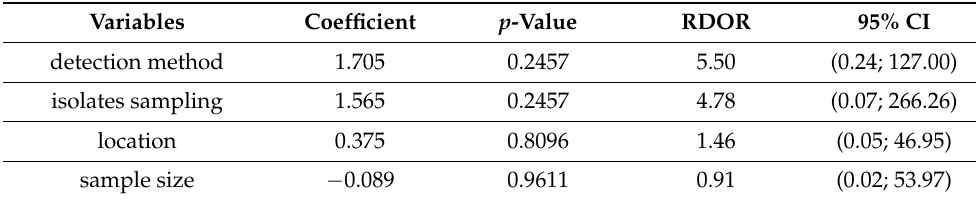
Table 5. Meta-regression analysis of the detection method, isolates sampling, location, and sample size of the group 2–128